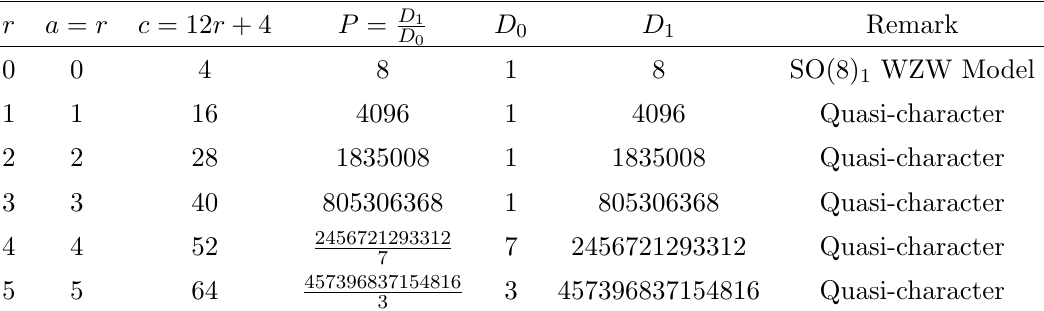
Table 6 . The D 4 series (Multiplicity M =